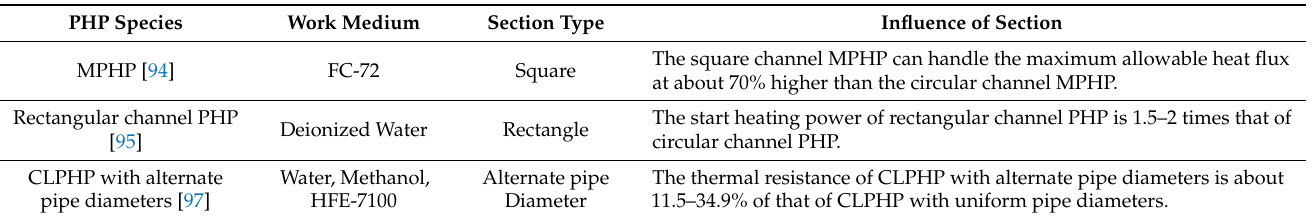
Table 1. Effect of PHP cross section on performance.